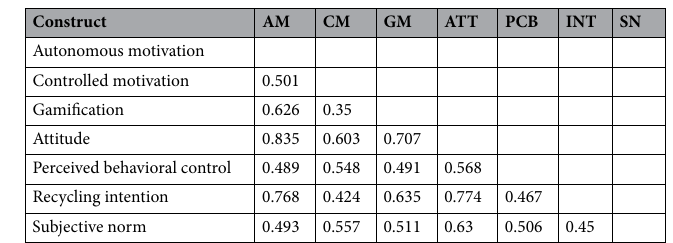
Table 3. Heterotrait-monotrait (HTMT). Shaded boxes are the standard reporting format for HTMT procedure. Source: Adapted from Henseler 80 , Hair et al. 77 and data research.